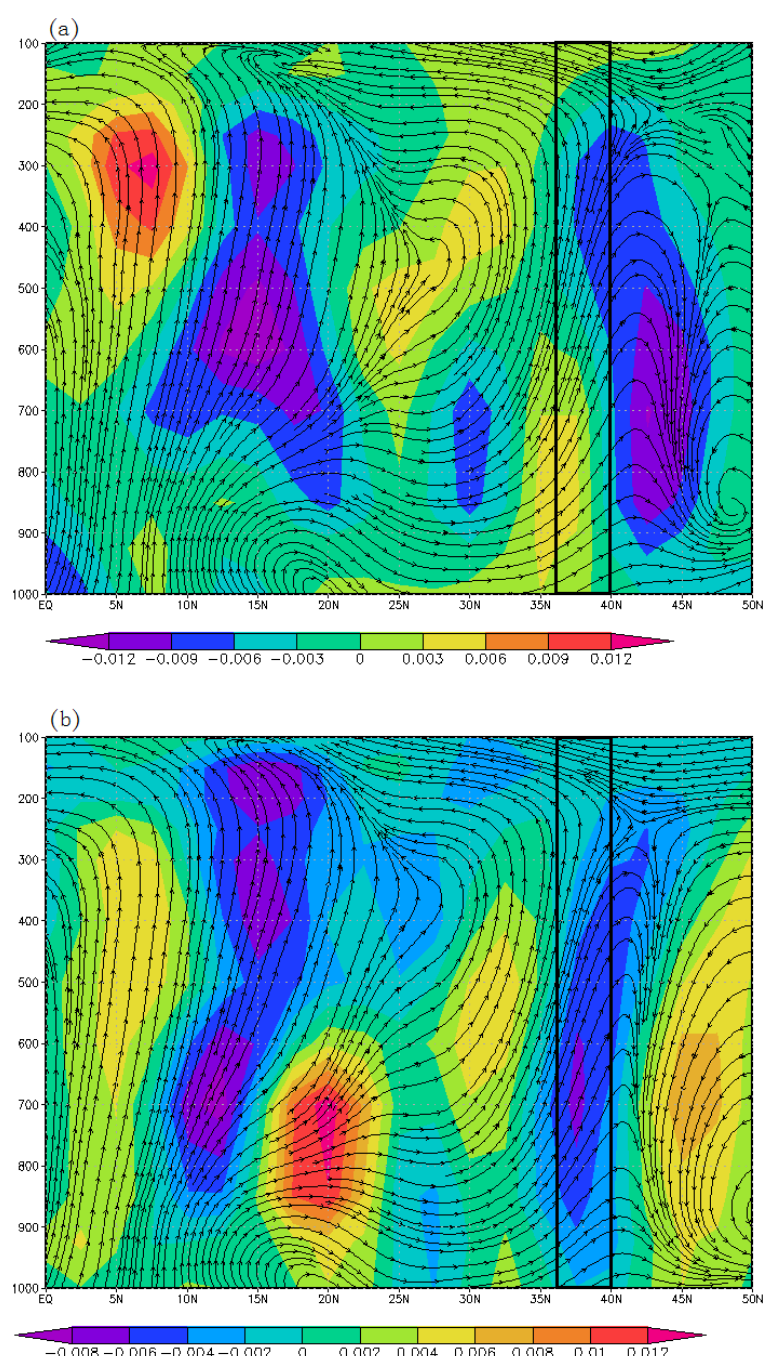
Figure 8. Average vertical circulations (streamlines) and anomalies of vertically velocity (shadows) in the summer of typical drought years ( a ) and flood years ( b ) within the longitudinal range from 106° E to 112° E. (Unit: Pa·s −1 ). The vertical wind velocity streamlines are intensified by 100 times. The rectangular areas indicate the study area.